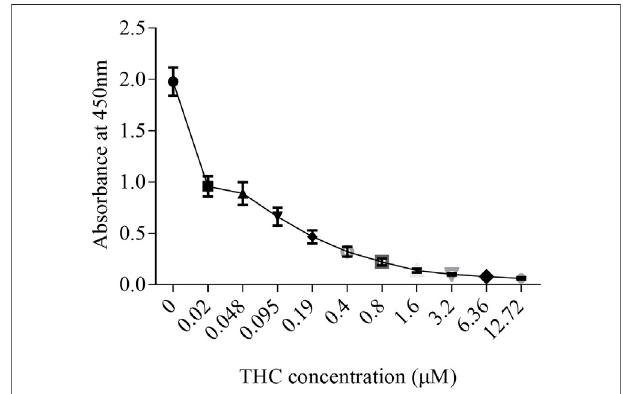
FIGURE 1 | The standard curve for Δ 9 -THC. Δ 9 -THC was diluted in ELISAbufferfromastartingconcentrationof1 mg/mltoanupperlimitof4 μ g/ ml. Then, the concentration of this Δ 9 -THC standard curve was ranged from 0 μ g/ml (buffer only)- 4 μ g/ml (0 – 12.7 µM). Results are expressed as the mean ± SEM of two to four independent experiments.